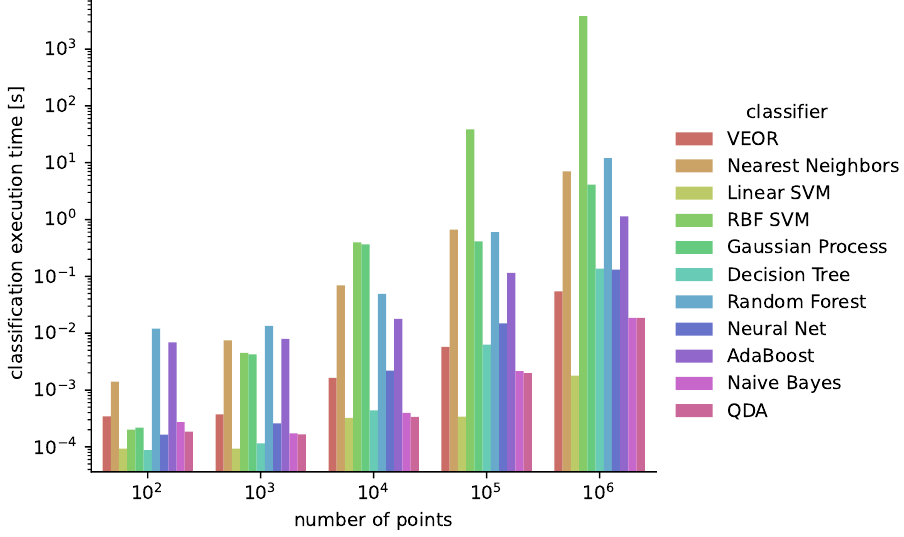
Figure 10. Comparison of single-core algorithm classification processing times for selected